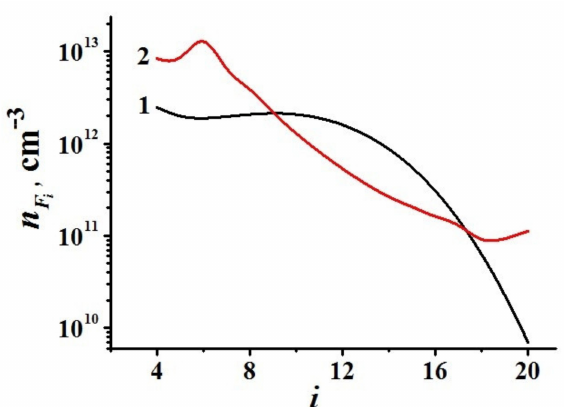
Figure 18. Concentrations of solid particles of groups F i depending on their size. Index i characterizes a solid particle containing 2 i aromatic rings. Curve 1 is obtained taking into account the charging of solid particles, while Curve 2 is obtained without taking into account charging. The volume fraction of argon is θ = 80%. The absorbed microwave power is 100